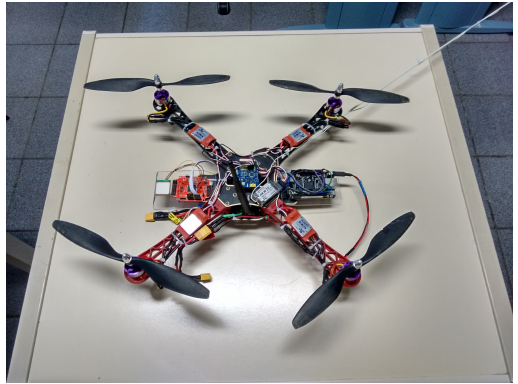
Figure 3. UAV equipped with the communication